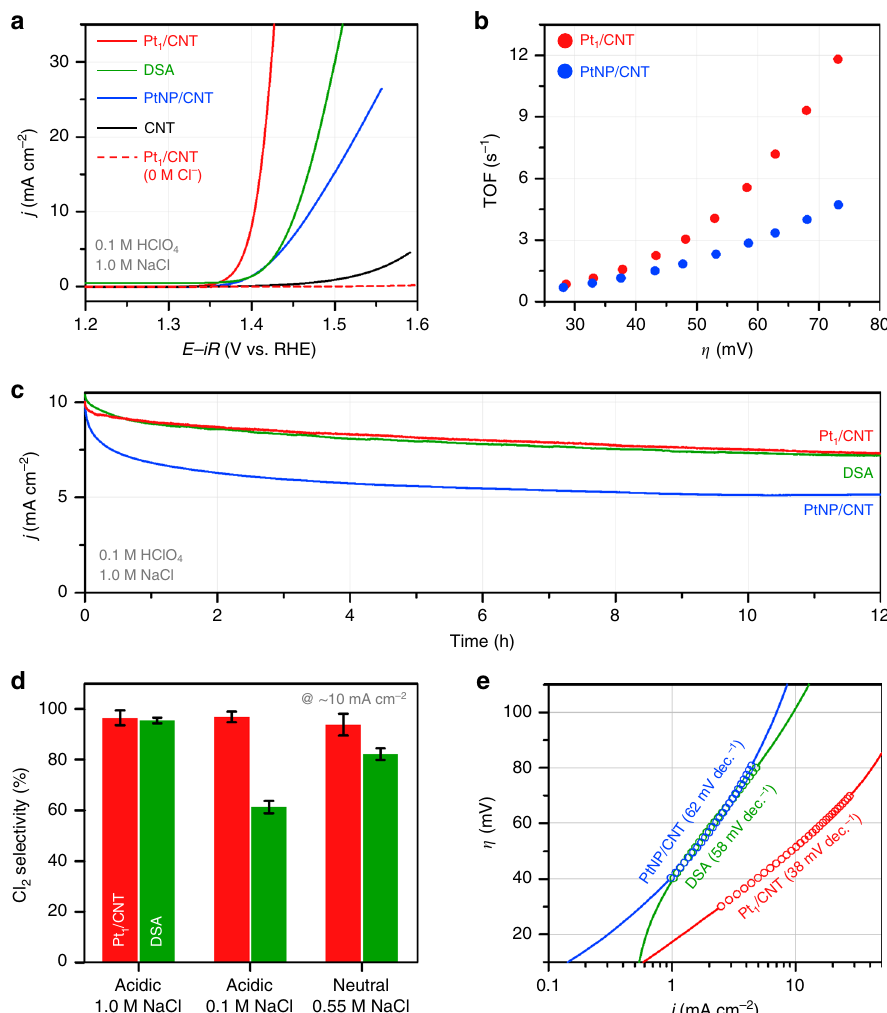
Fig. 2 CER performance of Pt 1 /CNT catalyst compared to its NP counterpart and dimensionally stable anode (DSA) catalyst. a CER polarisation curves of Pt 1 /CNT, PtNP/CNT, DSA and CNT catalysts obtained in 0.1 M HClO 4 + 1.0 M NaCl at an electrode rotation speed of 1600 rpm and a scan rate of 10 mV s − 1 . The polarisation curve of Pt 1 /CNT catalyst measured in 0.1 M HClO 4 is also shown. The DSA catalyst (1 cm × 1 cm) was measured without electrode rotation. b Calculated turnover frequencies (TOFs) of Pt 1 /CNT and PtNP/CNT catalysts corresponding to Fig. 2a. c Chronoamperograms of Pt 1 / CNT and PtNP/CNT catalysts deposited on a carbon paper (1 cm × 1 cm) and DSA catalyst (1 cm × 1 cm) measured in 0.1 M HClO 4 + 1.0 M NaCl for 12 h with a stirring speed of 300 rpm. d CER selectivity of Pt 1 /CNT and DSA catalysts measured by iodometric titration under different electrolyte conditions. The error bars indicate the standard deviation of three independent titrations. e Tafel plots of Pt 1 /CNT, PtNP/CNT and DSA catalysts. Their Tafel slopes are denoted in